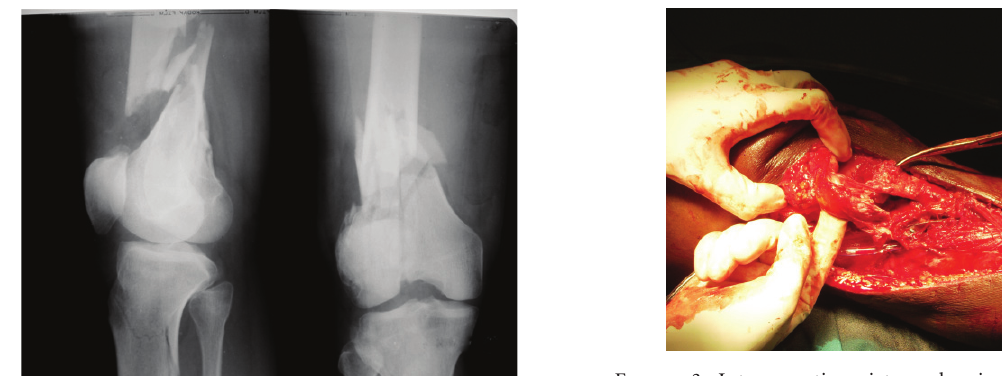
Figure 3: Intraoperative picture showing torn ends of patellar tendon.